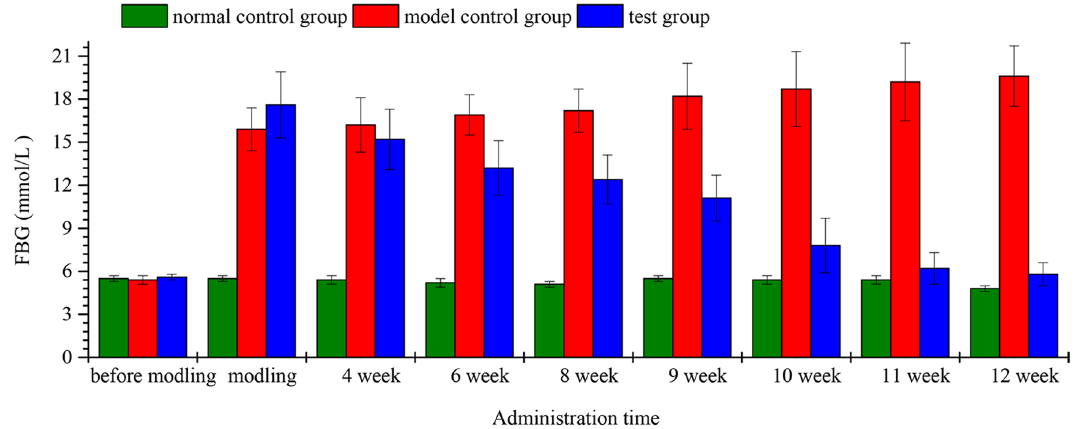
Figure 3. FBG changes of rats with different diets. Data are mean values ± standard errors of three